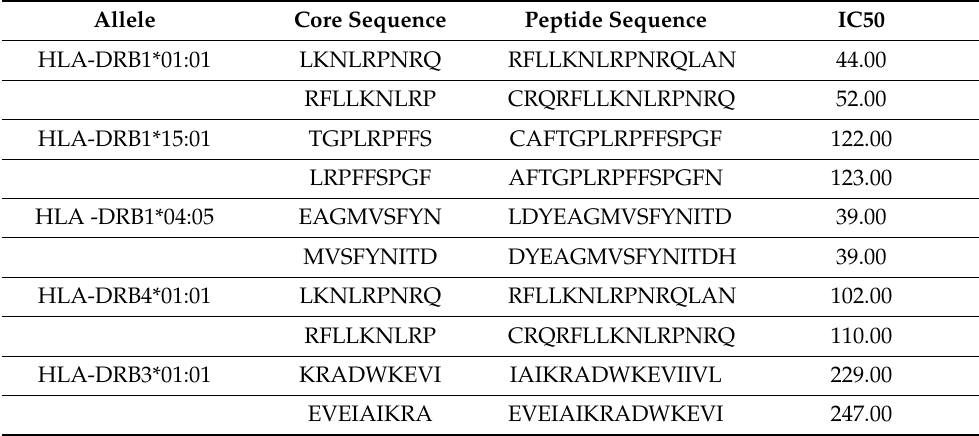
Table 9. Predicted peptides on risk alleles for human